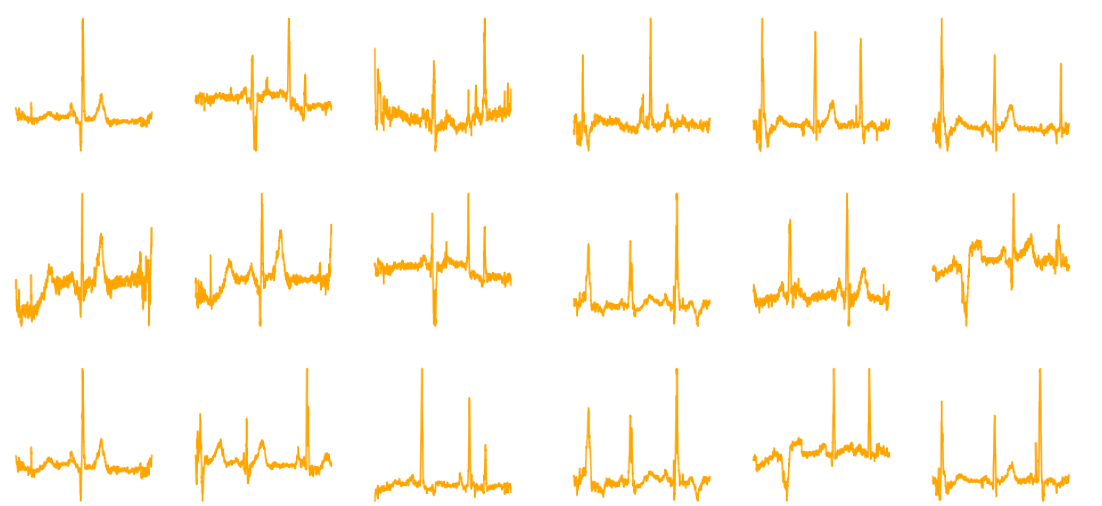
Figure 12. ( Left ) Generated samples for the transposed model. ( Right ) Generated samples for the reversed